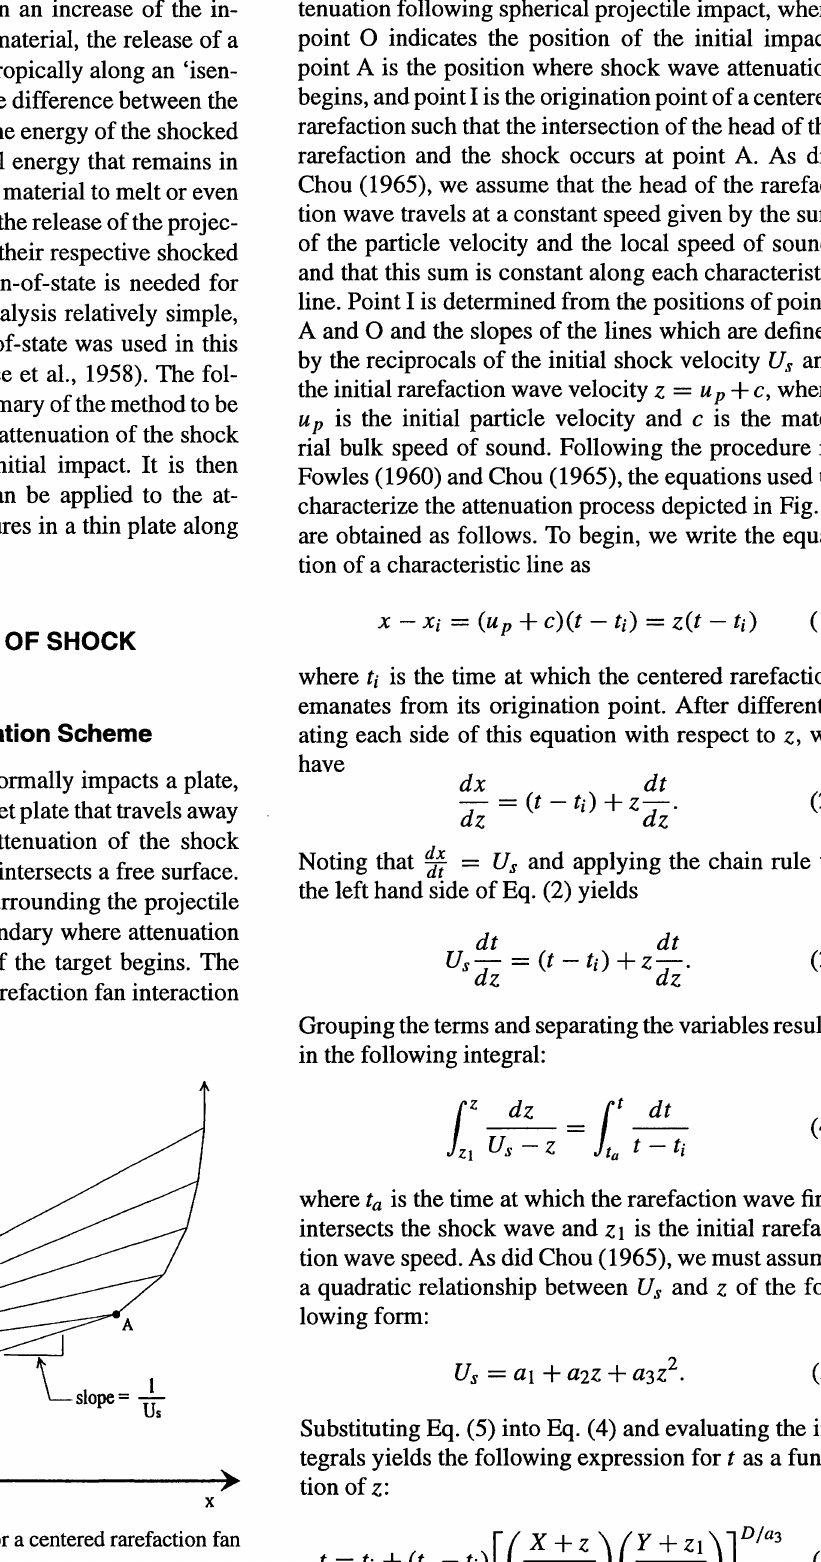
FIGURE 1 The x-t diagram for a centered rarefaction fan overtaking a shock